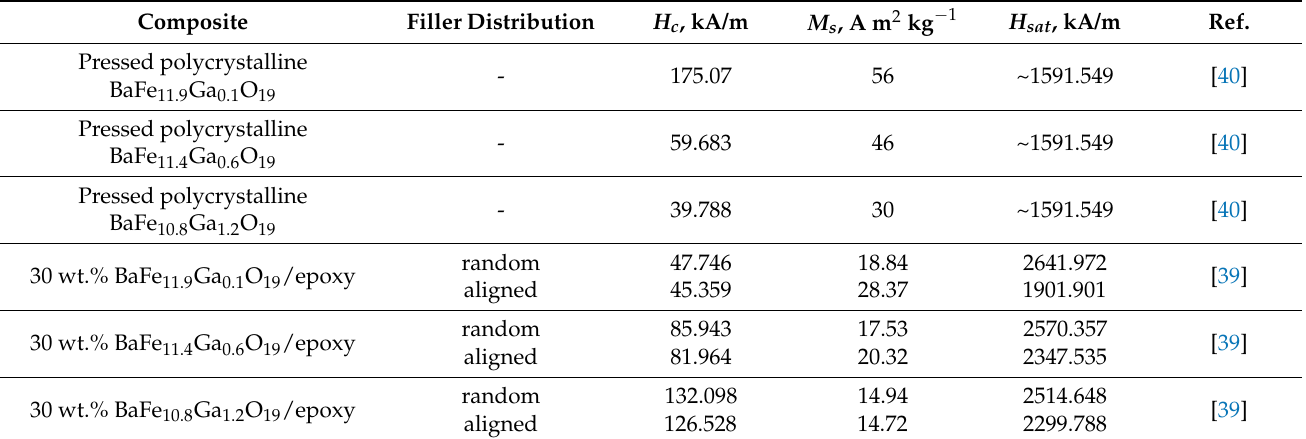
Table 2. The magnetic parameters of pressed BaFe 12– x Ga x O 19 samples and 30 wt.% BaFe 12– x Ga x O 19 /epoxy composites (x = 0.1–1.2) with random and aligned distributions of fillers in the epoxy